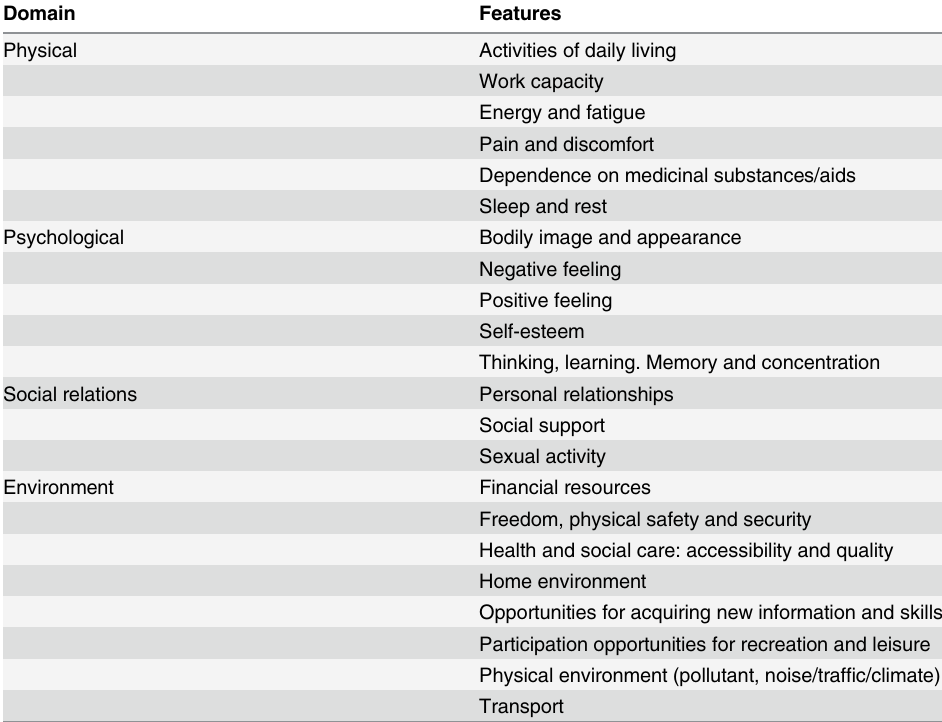
Table 1. Summary of WHOQOL-BREF survey components